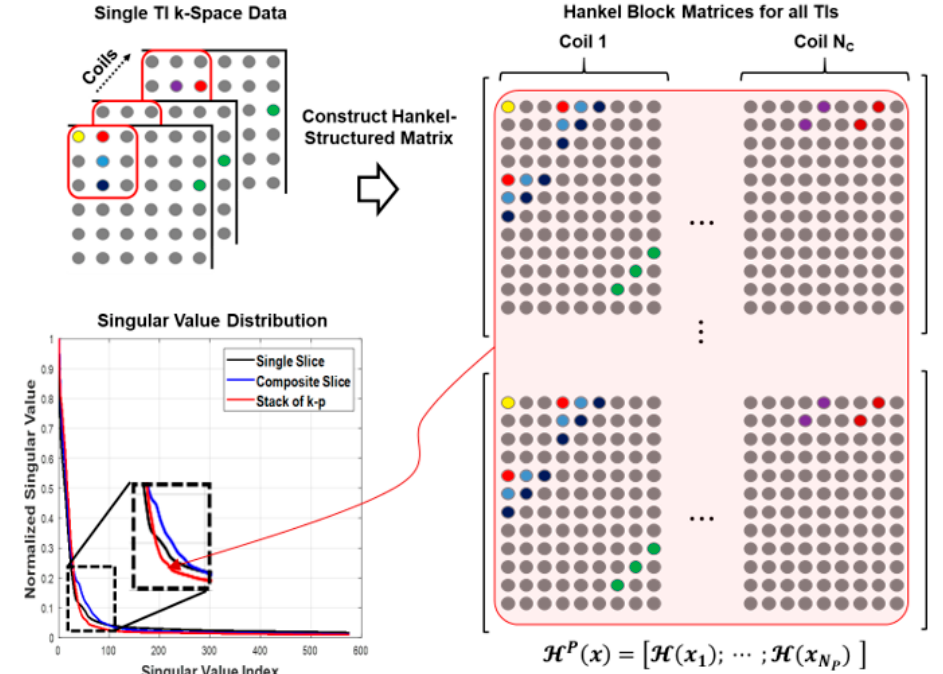
Figure 1. An illustration of the use of null space for slice separation. This work hypothesizes that the null space is invariant along the parameter dimension. The null space projection effectively fil- ters out a slice of no interest while passing through a slice of interest regardless of contrast changes.